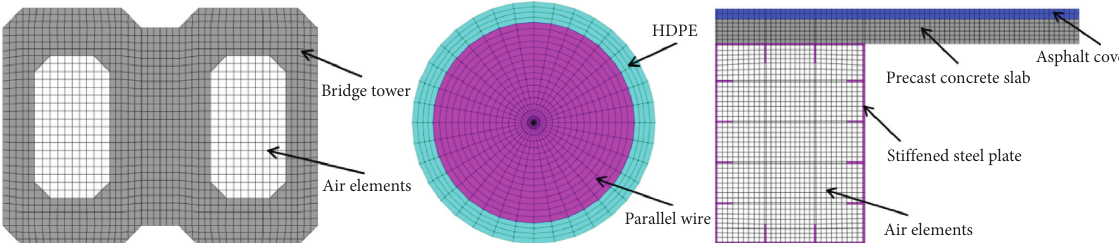
Figure 3: The heat transfer analysis in the finite element